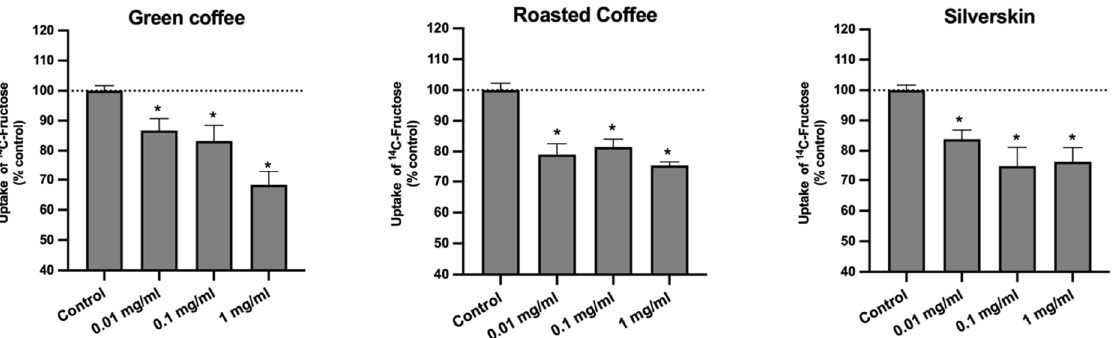
Figure 4. Effect of green coffee, roasted coffee, and coffee silverskin extracts on the uptake of 14 C-FRU by Caco-2 cells. Caco-2 cells were cultured for 24 h in the presence of different extract concentrations ( n = 9) or the respective solvent (control; n = 9). Uptake was measured by incubating Caco-2 cells at 37 ◦ C with 100 nM 14 C-FRU for 6 min. Results are expressed as means ± SEM. *, significantly different from control ( p < 0.05; Student’s t -test).